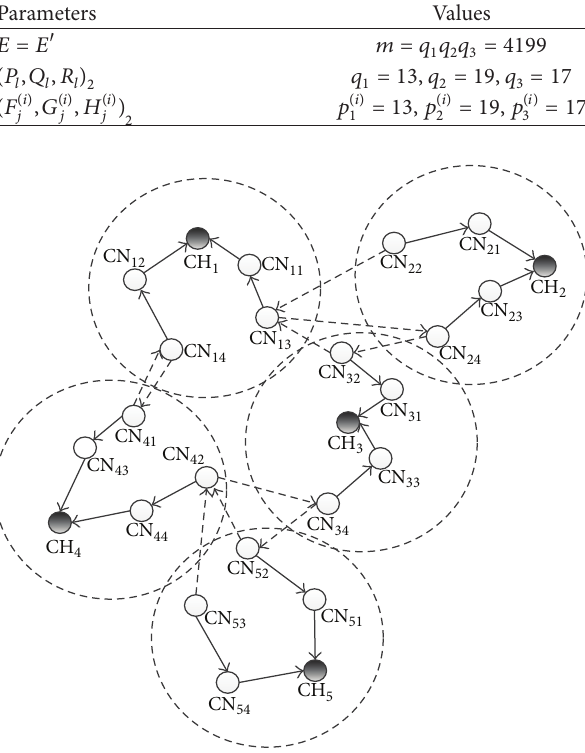
Figure 4: The slices of the edge